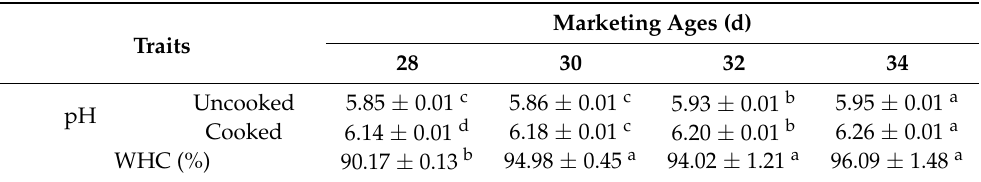
Table 2. pH and water-holding capacity (WHC) of uncooked and cooked cured chicken breast with various marketing